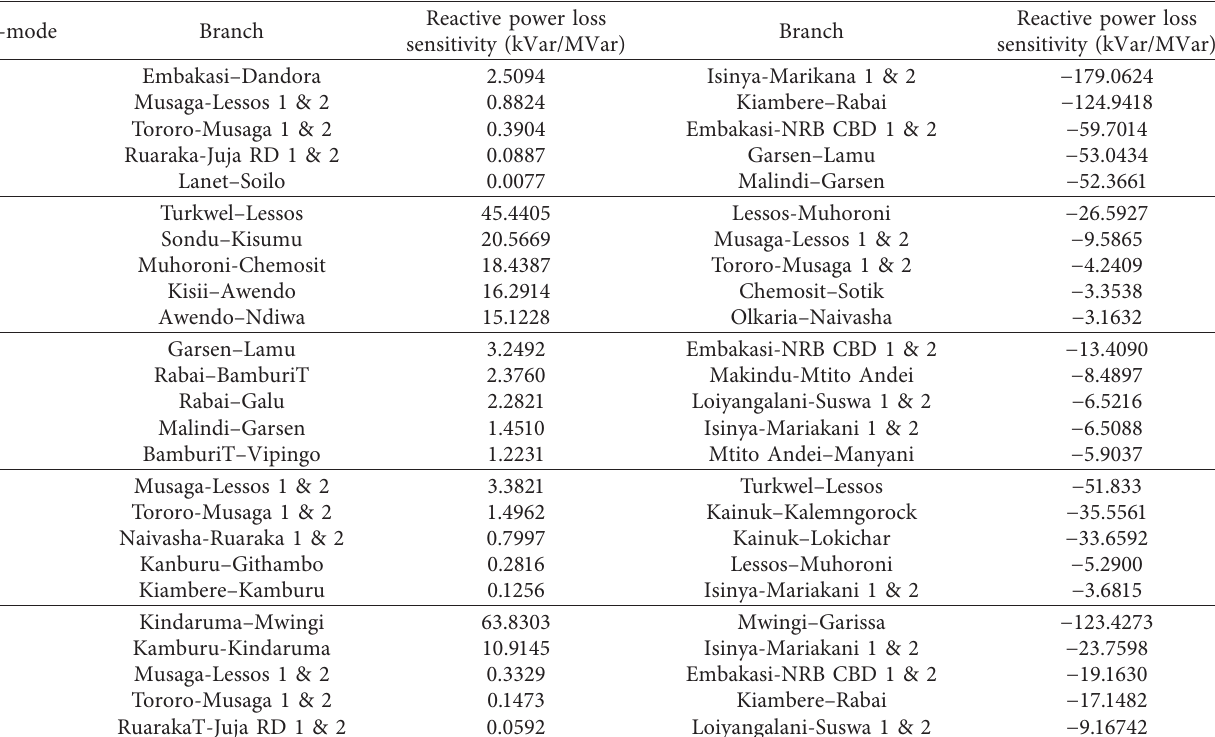
Table 6: Branch reactive power loss sensitivity